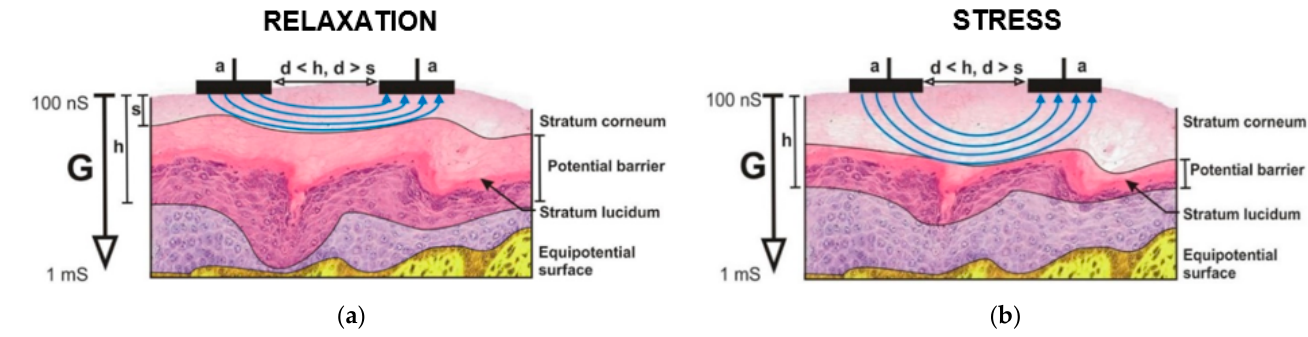
Figure 2. The dominant vector intensity lines of the electric field inside of human skin by using microelectrodes: ( a ) in relaxation, ( b ) under stress stimulus.